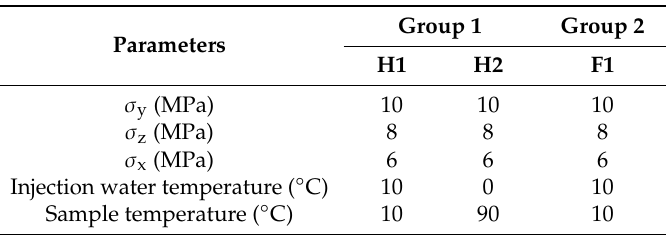
Table 2. Experiment